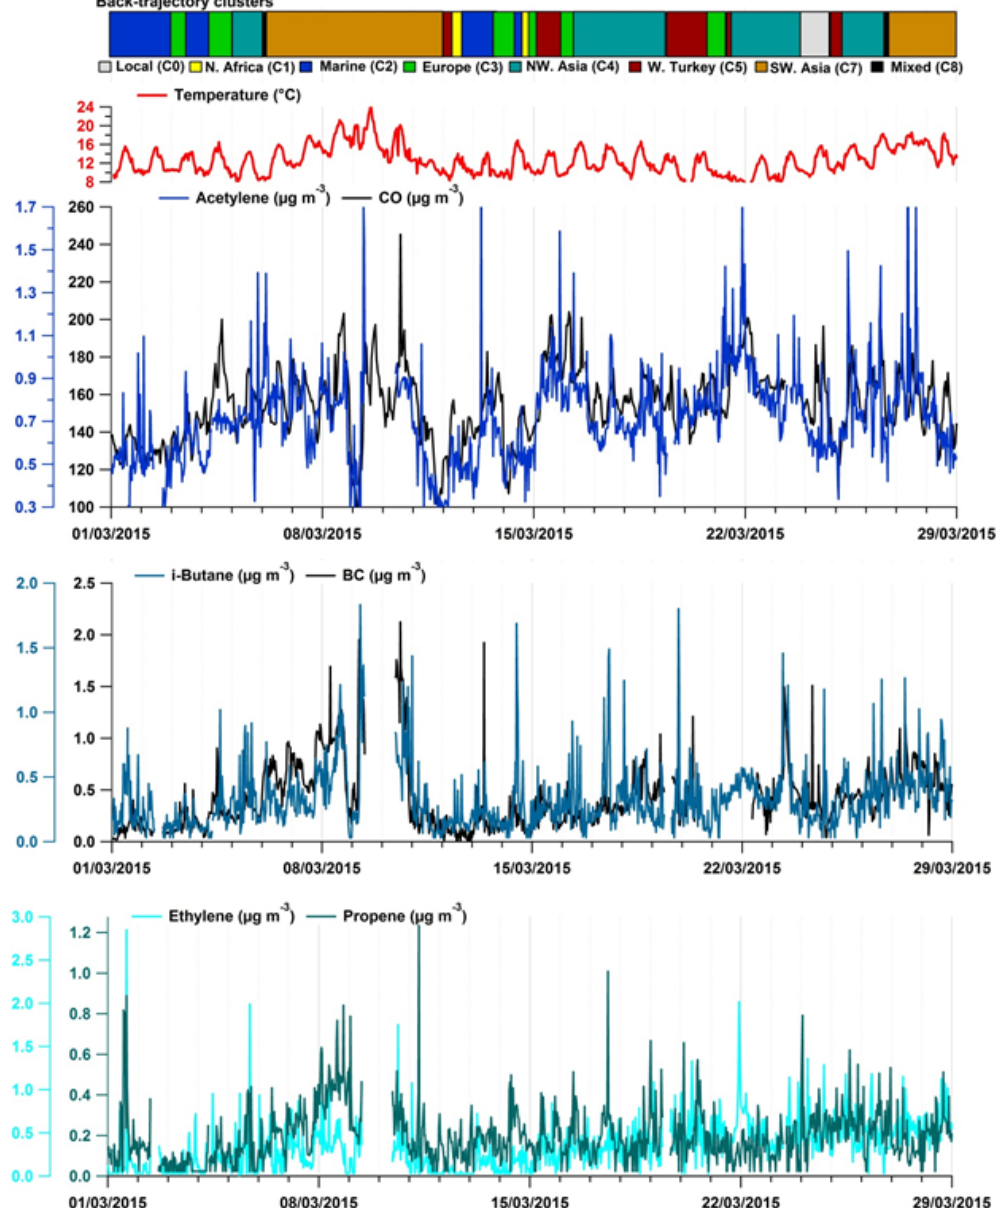
Figure 4. Time series of a selection of anthropogenic VOCs (acetylene, i -butane, ethylene and propene – blue lines) in comparison with air mass origin, meteorological parameters (temperature displayed as red lines) and air combustion tracers (CO and BC – black